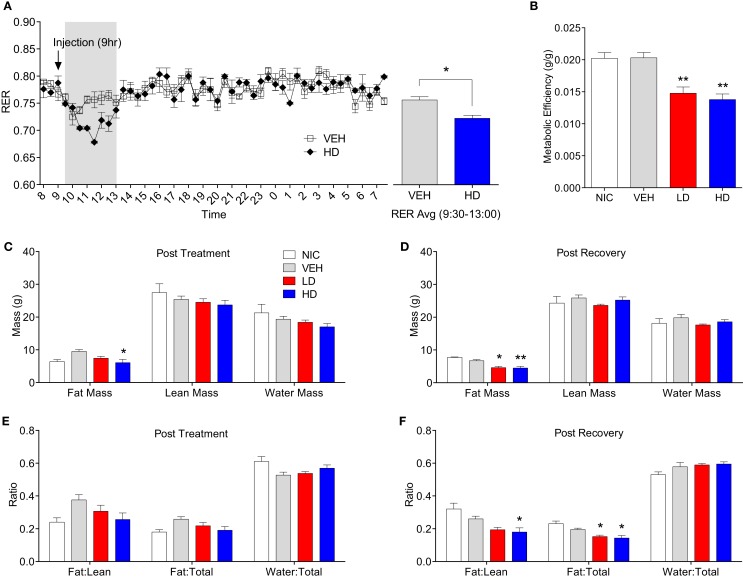
Twenty-four hour respiratory exchange ratio following 8 days of vehicle and CF801 (high dose) treatment [(A), left] and average RER during the 4-h period following injection at 09:00 hours [(A), right]. Metabolic efficiency (B); fat mass, lean mass, and water mass following treatment period (C) and recovery period (D); fat mass:lean mass, fat mass:total mass, and water mass:total mass following treatment period (E) and recovery period (F). All values are expressed as mean ± SEM. *p < 0.05, **p < 0.01 compared to VEH-treated animals.